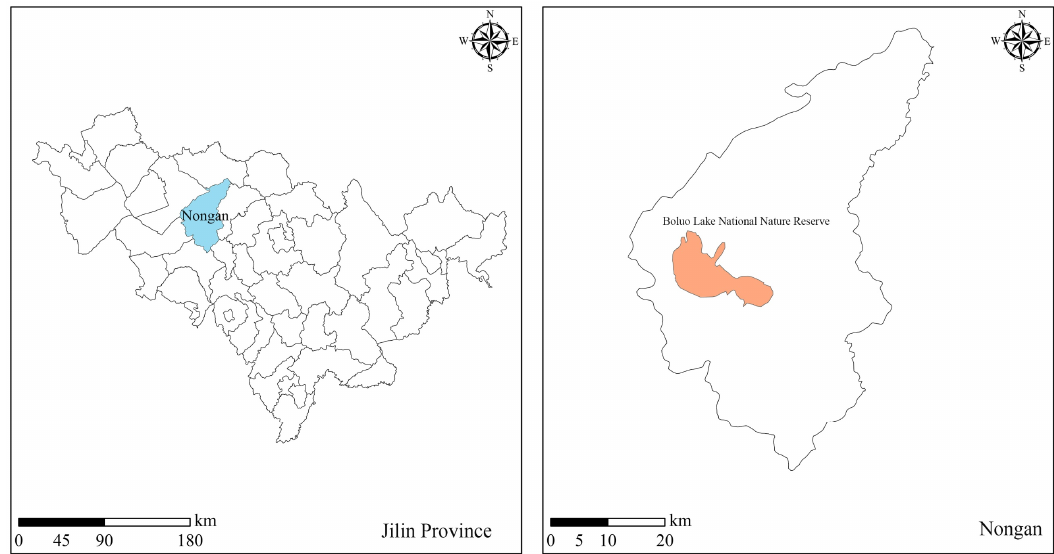
Figure 1. Geographical location of study area.